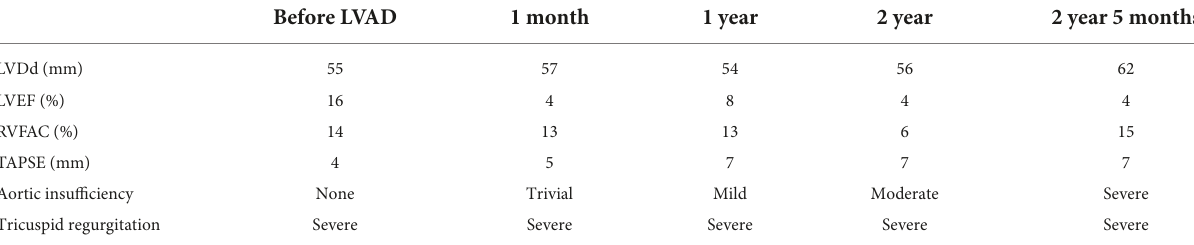
TABLE 3 Trend of echocardiographic data in Case 1.